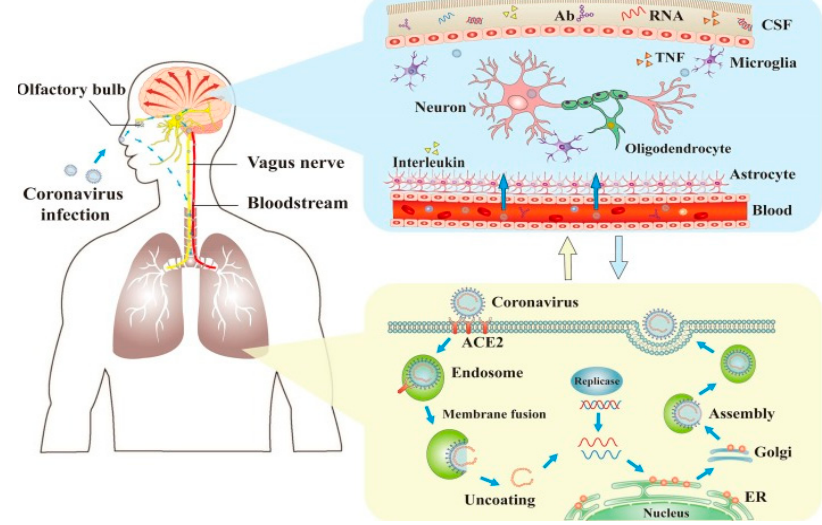
Figure 5. Mechanisms of coronaviral infection of the brain. SARS-CoV-2 can enter the nervous system directly through the olfactory nerve, and also through blood circulation and neuronal pathways, resulting in neurological disorders. Ab: antibody; ACE2: angiotensin-converting enzyme 2; CSF: cerebrospinal fluid; ER: endoplasmic reticulum; TNF: tumor necrosis factor. [72].